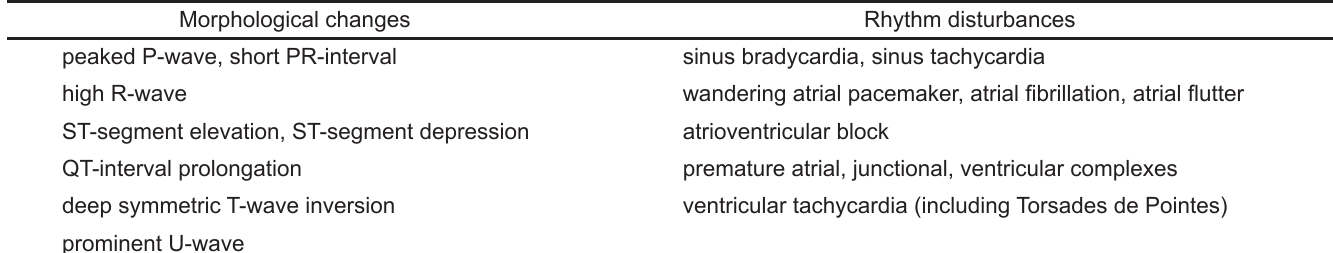
Table 2. Electrocardiographic findings in subarachnoid hemorrhage, modified from references.